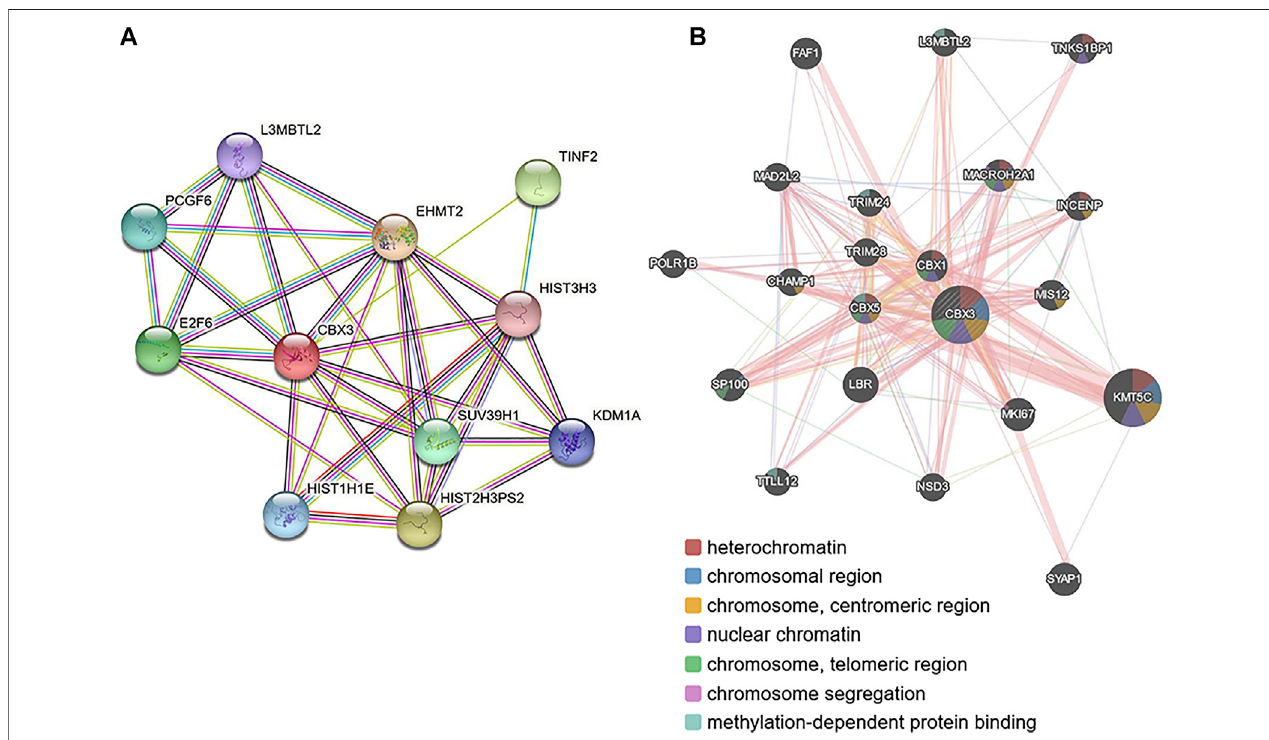
FIGURE 6 | Protein – protein interaction network of different expressed CBX3 (A) STRING (https://string-db.org/) (B) GeneMANIA (http://www.genemania.org).